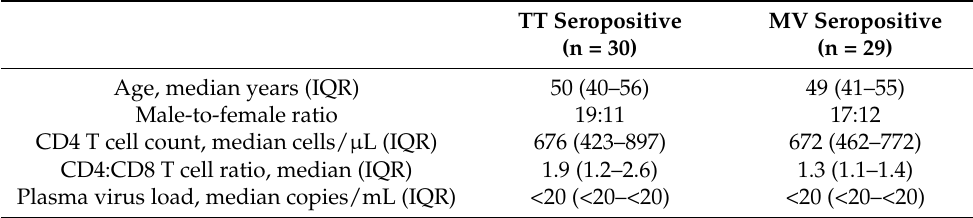
Table 1. Characteristics of TT- and MV-seropositive ART-treated HIV-infected study